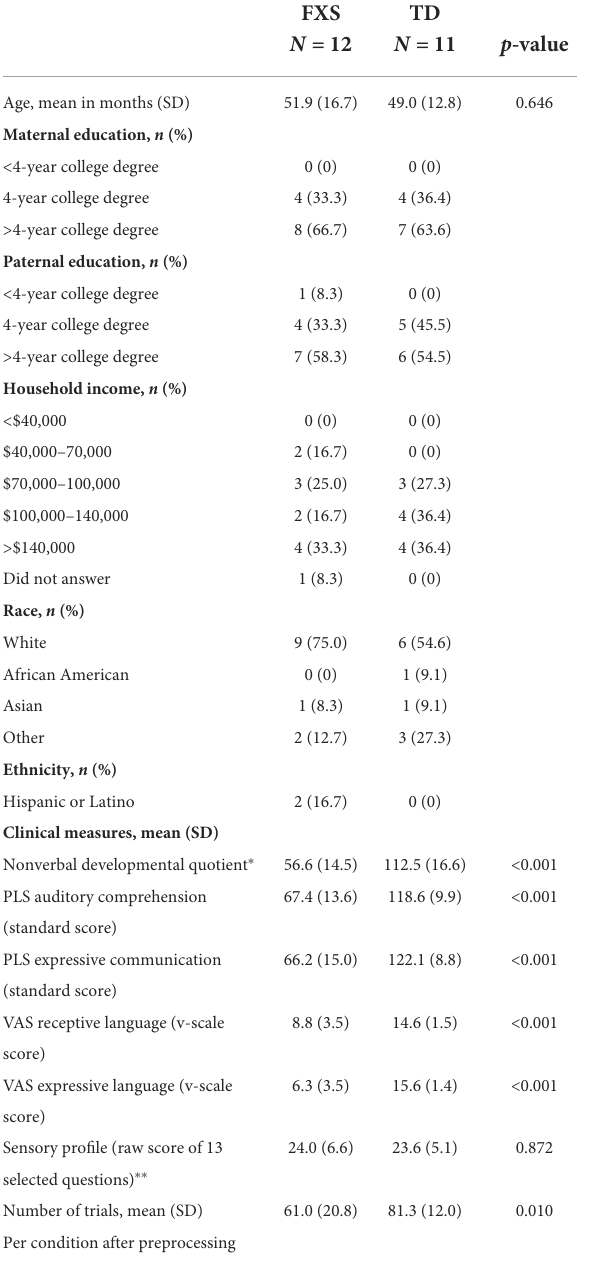
TABLE 1 Sample characteristics.